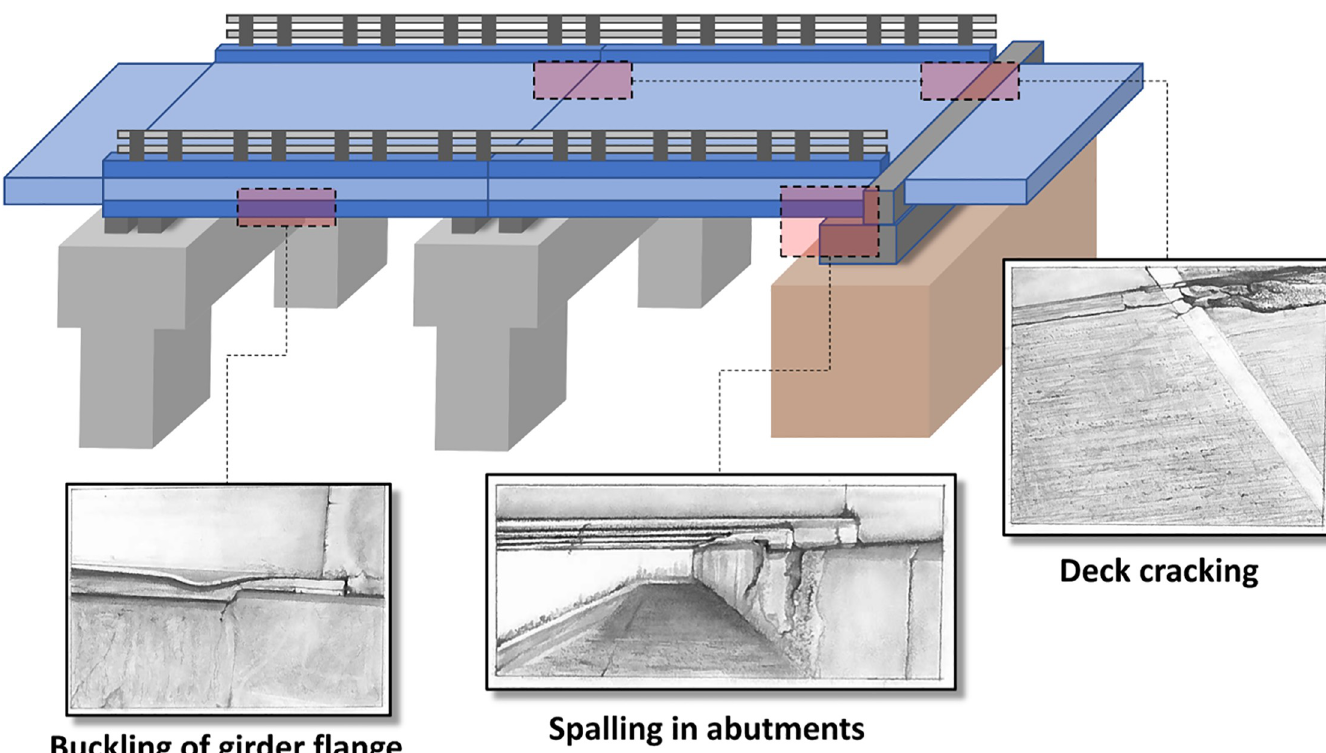
Fig 2. Potential bridge damages caused by the combination of clogged joint condition and unpredicted thermal stresses.